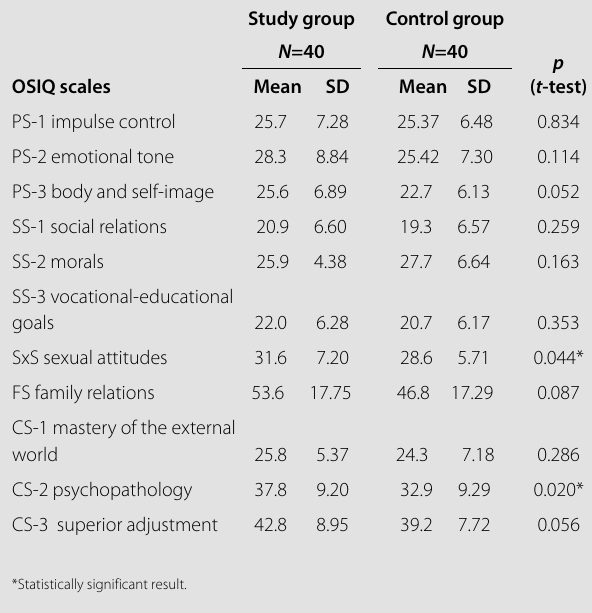
Table 1. OSIQ results for the study and control